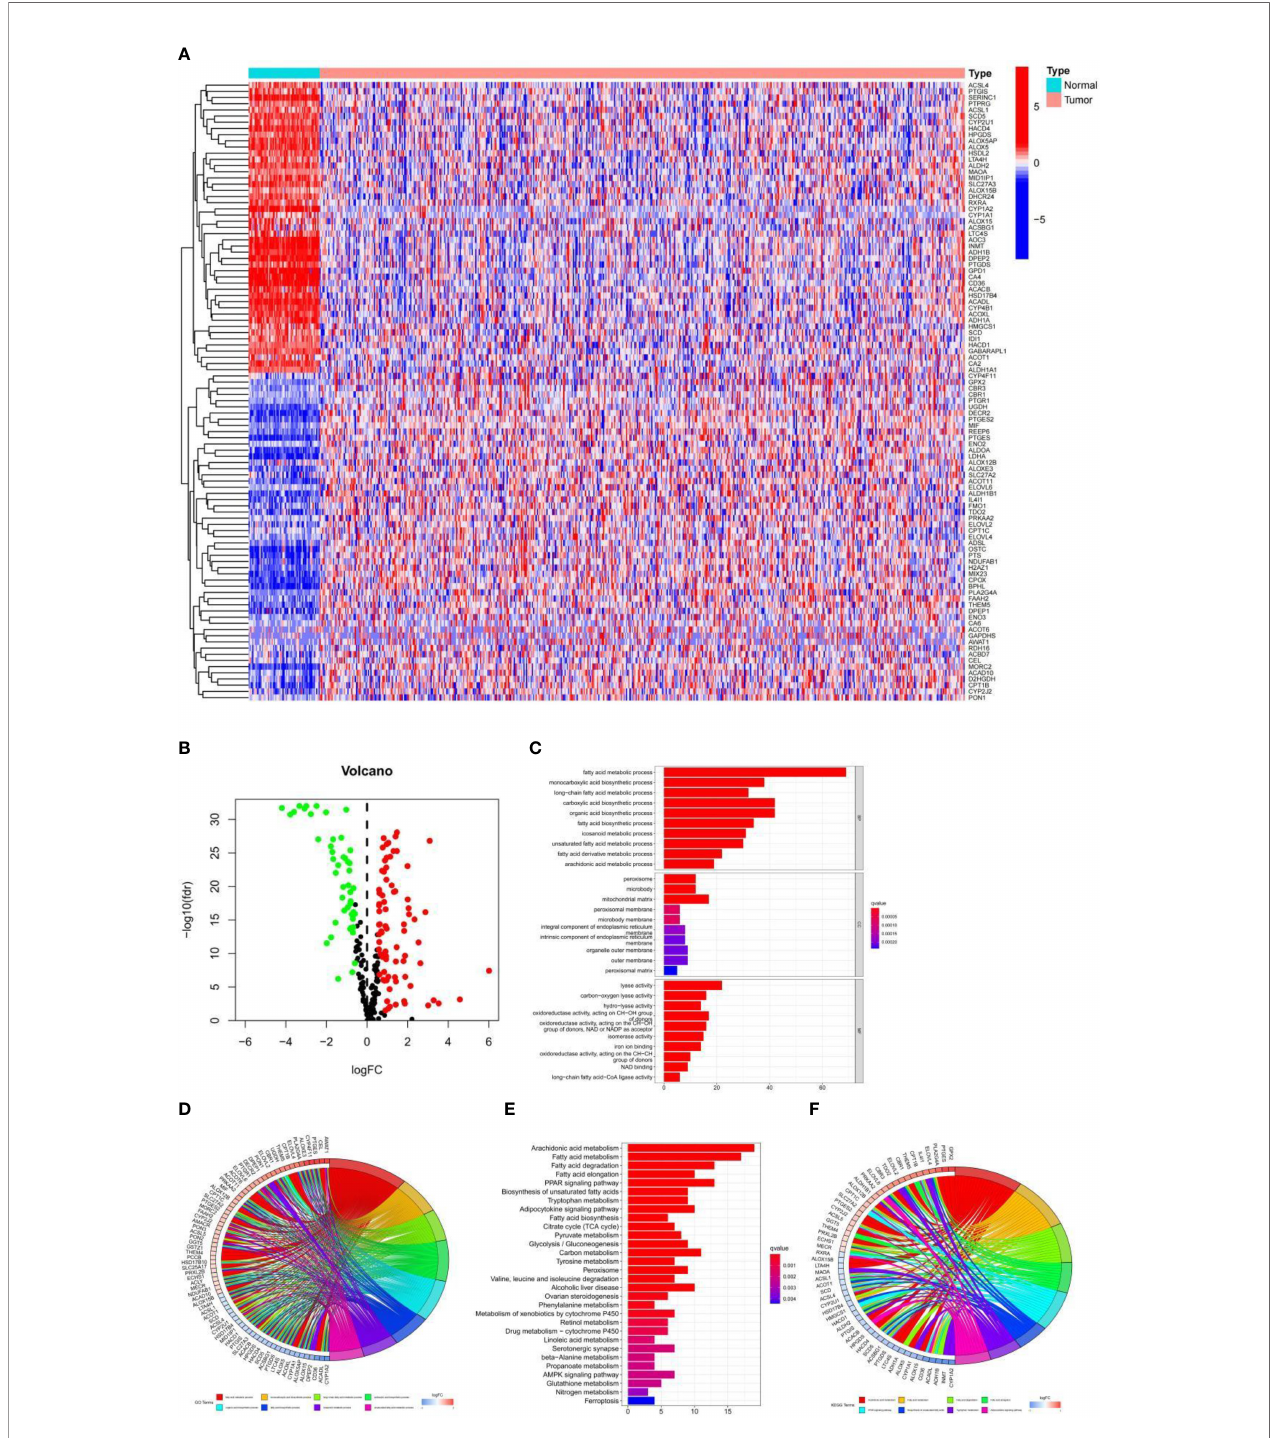
FIGURE 1 | (A) Heat map of 126 genes in the TCGA-LUAD cohort. (B) Volcano map of the 126 fatty acid metabolism-related differential genes in the TCGA-LUAD cohort. (C, D) GO analysis of fatty acid metabolism-related differential genes in the TCGA-LUAD cohort. (E, F) KEGG analysis of fatty acid metabolism-related differential genes in the TCGA-LUAD